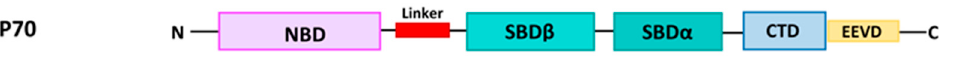
Figure 5. Domain organization of Hsp70. N-terminal, nucleotide-binding domain (NBD), substrate-